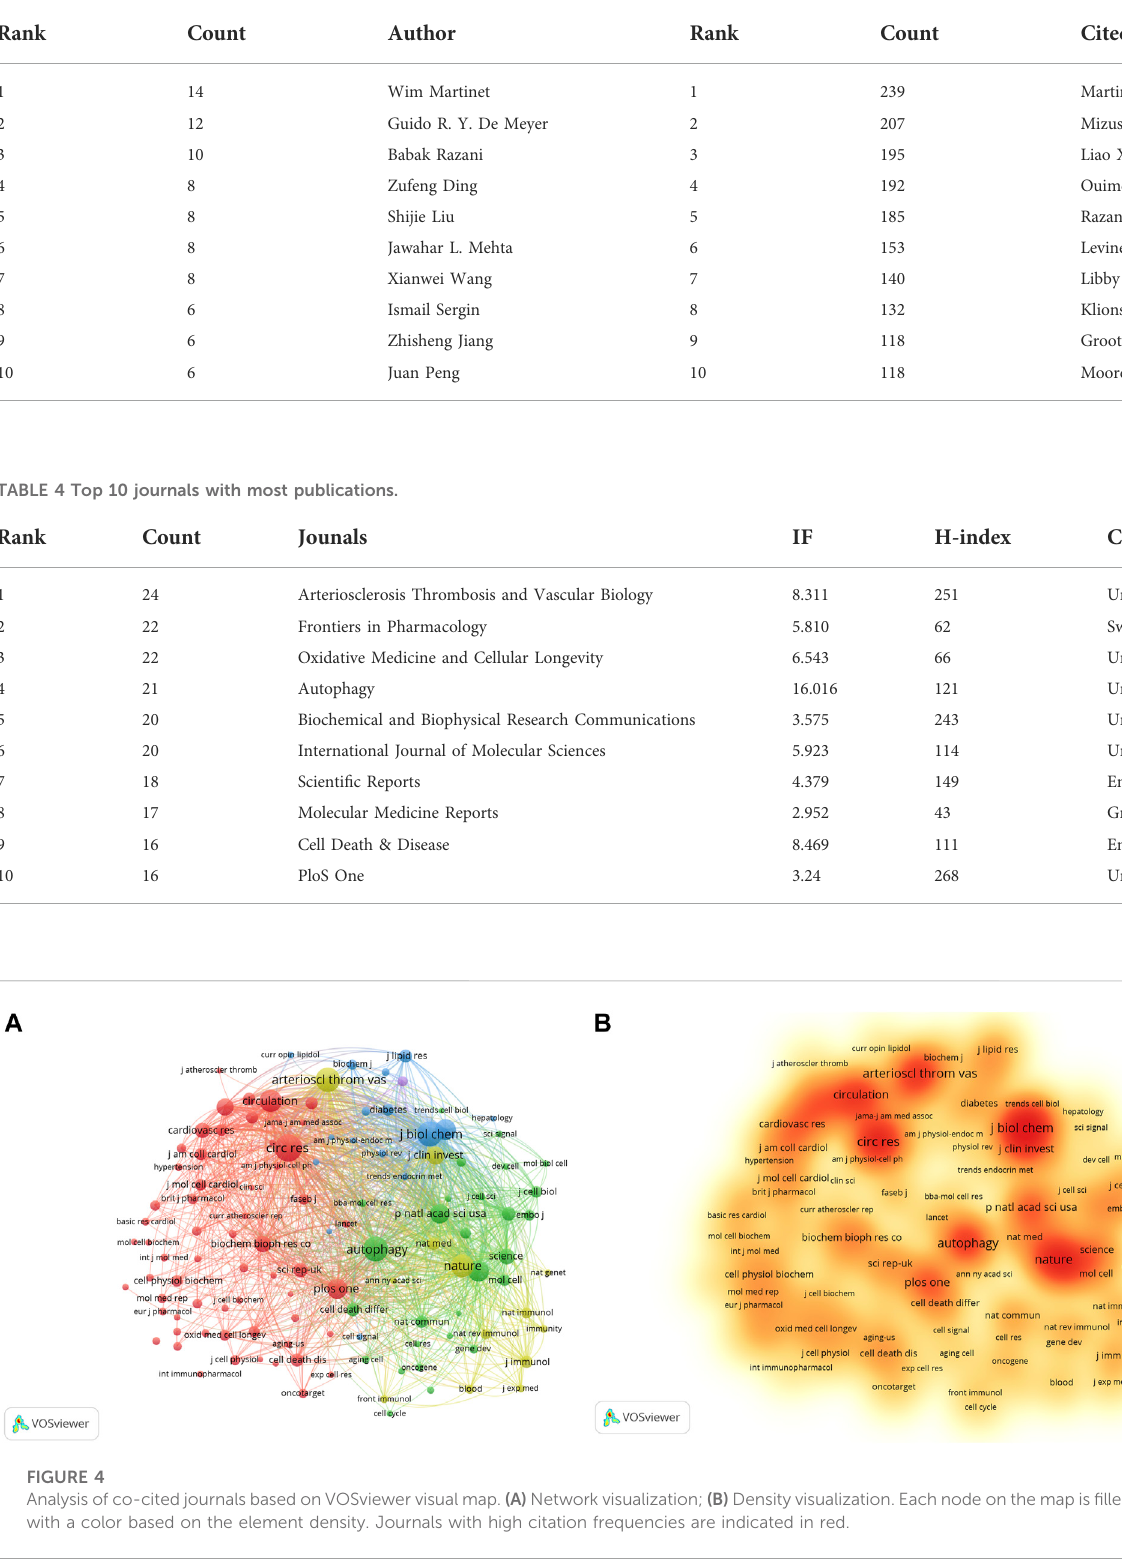
TABLE 3 Top 10 most productive authors distributed by publications and citations.